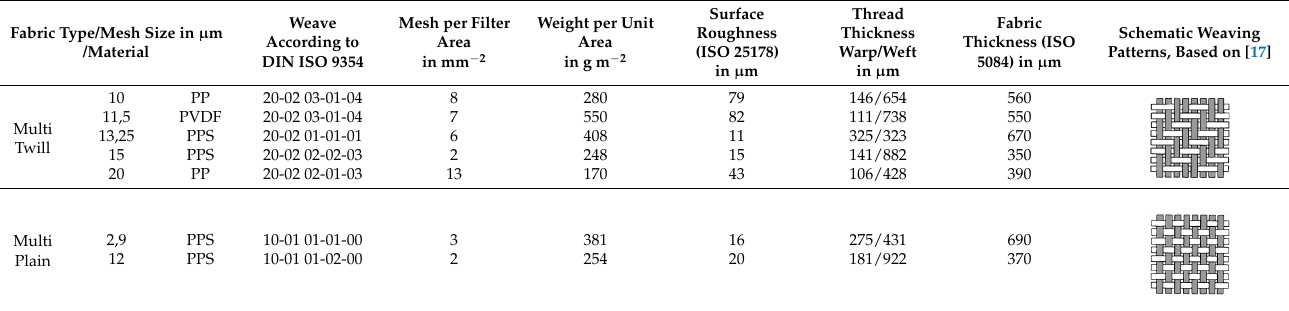
Table 2. Overview of polymer-based multifilament fabrics.